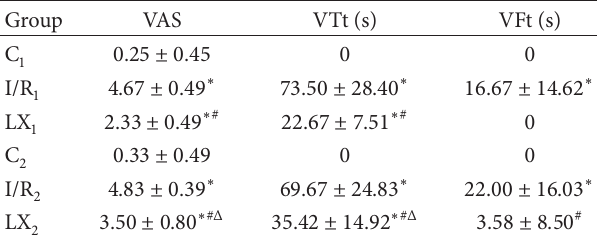
Table 1: The ventricular arrhythmia score (VAS), the duration time of VT (VTt) and VF (VFt) in different groups at T 3 ( 𝑛 = 12 , mean ±